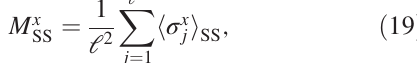
FIG. 8. Two-dimensional cluster mean-field phase diagram in the J x − J y plane (with fixed J z ¼ 1 ). The single-site MF ( 1 × 1 ) predicts a ferromagnetic steady state in the top left region with respect to the black curve. The extent of this region appears to be very fragile to a more accurate cluster mean-field treatment. At the 2 × 2 level (red squares), the boundaries of the two phases are slightly deformed, while with a 3 × 3 analysis, the FM phase shrinks down to a region of finite size (blue circles). The darkest color filling indicates the region that is PM in all simulations, while the lightest indicates that which is FM in all cases. The FM region shrinks with increasing cluster size, as indicated by the varying shades of color but, as discussed in the text, appears to converge with increasing cluster size. The five arrows denote the cuts along different values of J x , which will be analyzed in detail in Figs. 9 and